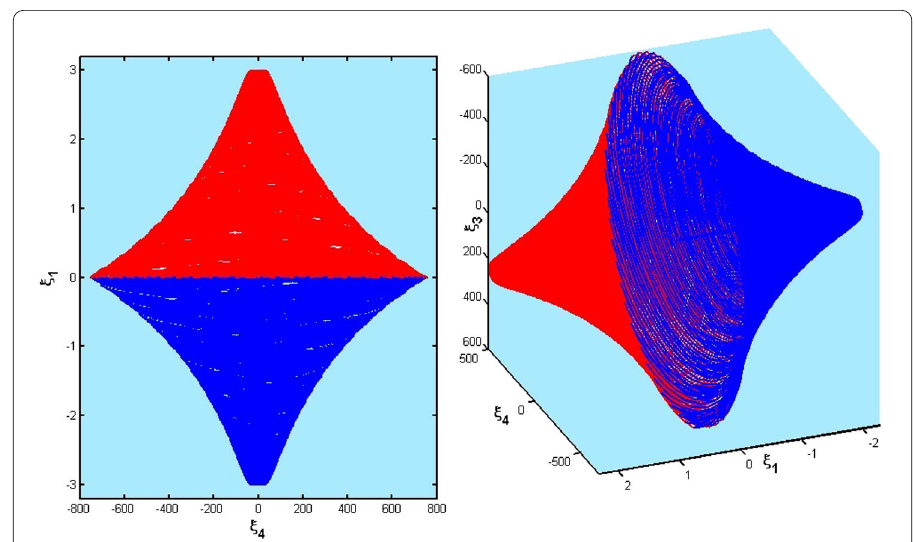
Figure 12 Invariant torus appears at K =